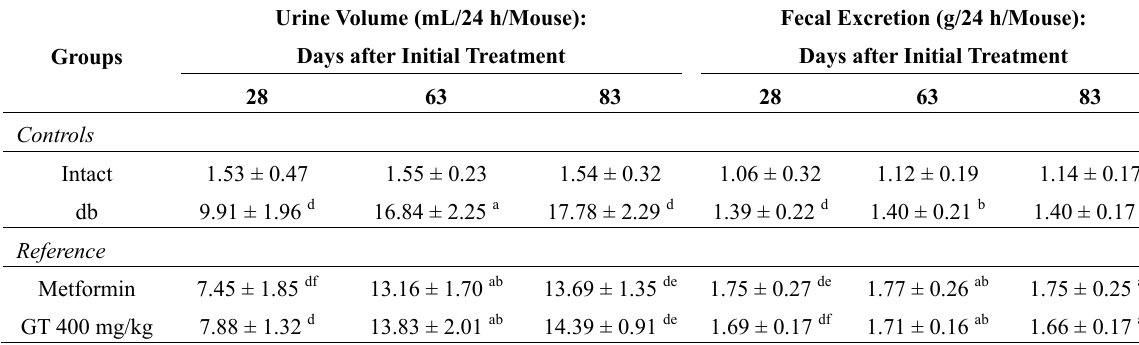
Table 2. Urine volumes and fecal excretion in intact normoglycemic and db/db mice.